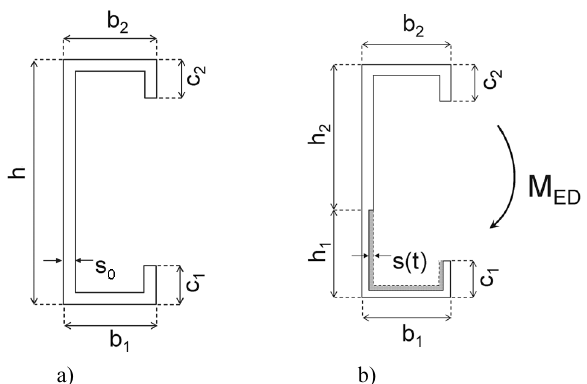
Fig. 3. The investigated C-lipped cross section: a) the as-built configuration; b) the assumed damage model at cross